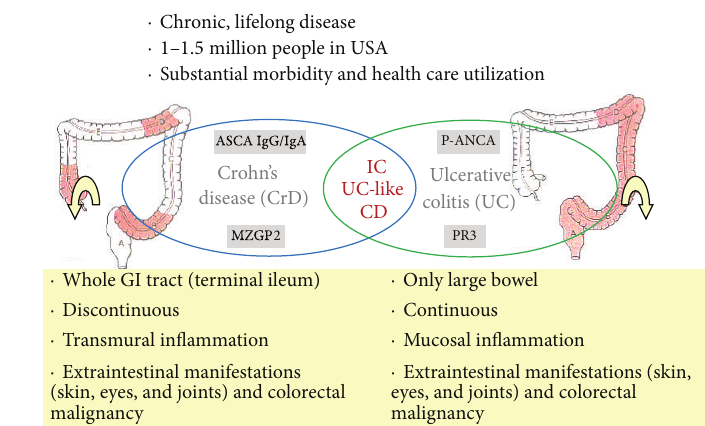
Figure 7: Differentiation between ulcerative colitis (UC) and Crohn’s disease (CrD). The clinical difference of UC and CrD and the potential role of PR3-ANCA as a marker to help in the diagnosis of UC are illustrated.